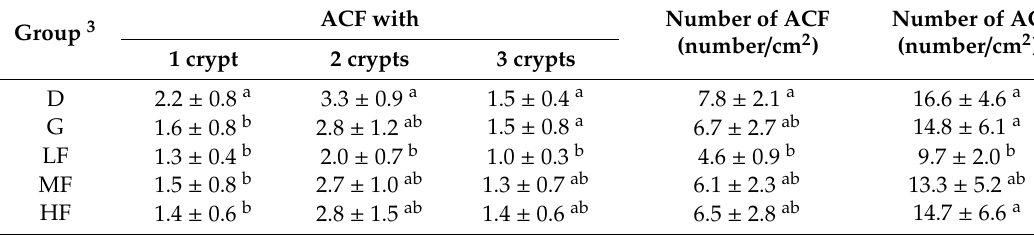
Table 2. E ff ects of GBR and FGBR on the numbers of DMH / DSS-induced ACF according to the type of mucin and MDF in the distal colon of F344 rats 1,2